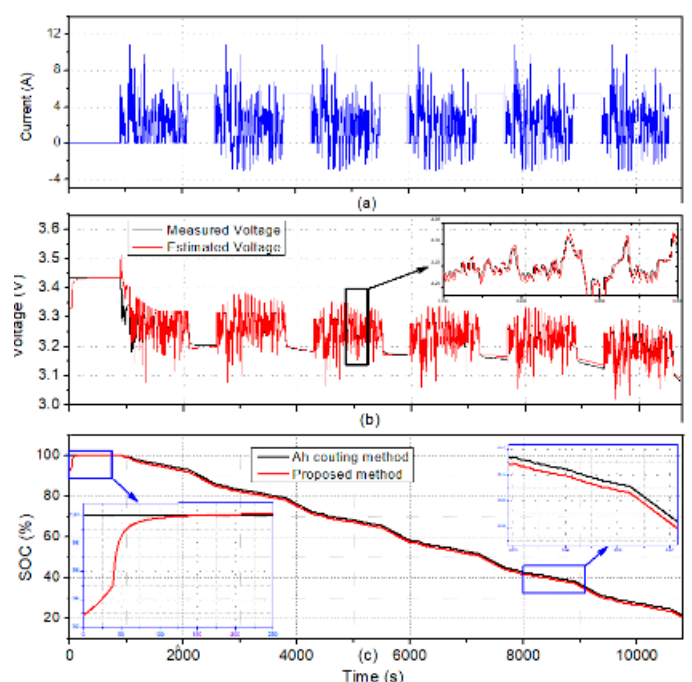
Figure 5. Experimental results: ( a ) Urban Dynamometer Driving Schedule (UDDS) current profile applied to the LiFePO4 battery; ( b ) Measured and estimated voltage of the battery; ( c ) State of charge (SOC) estimation result with the proposed method and Ah counting method.